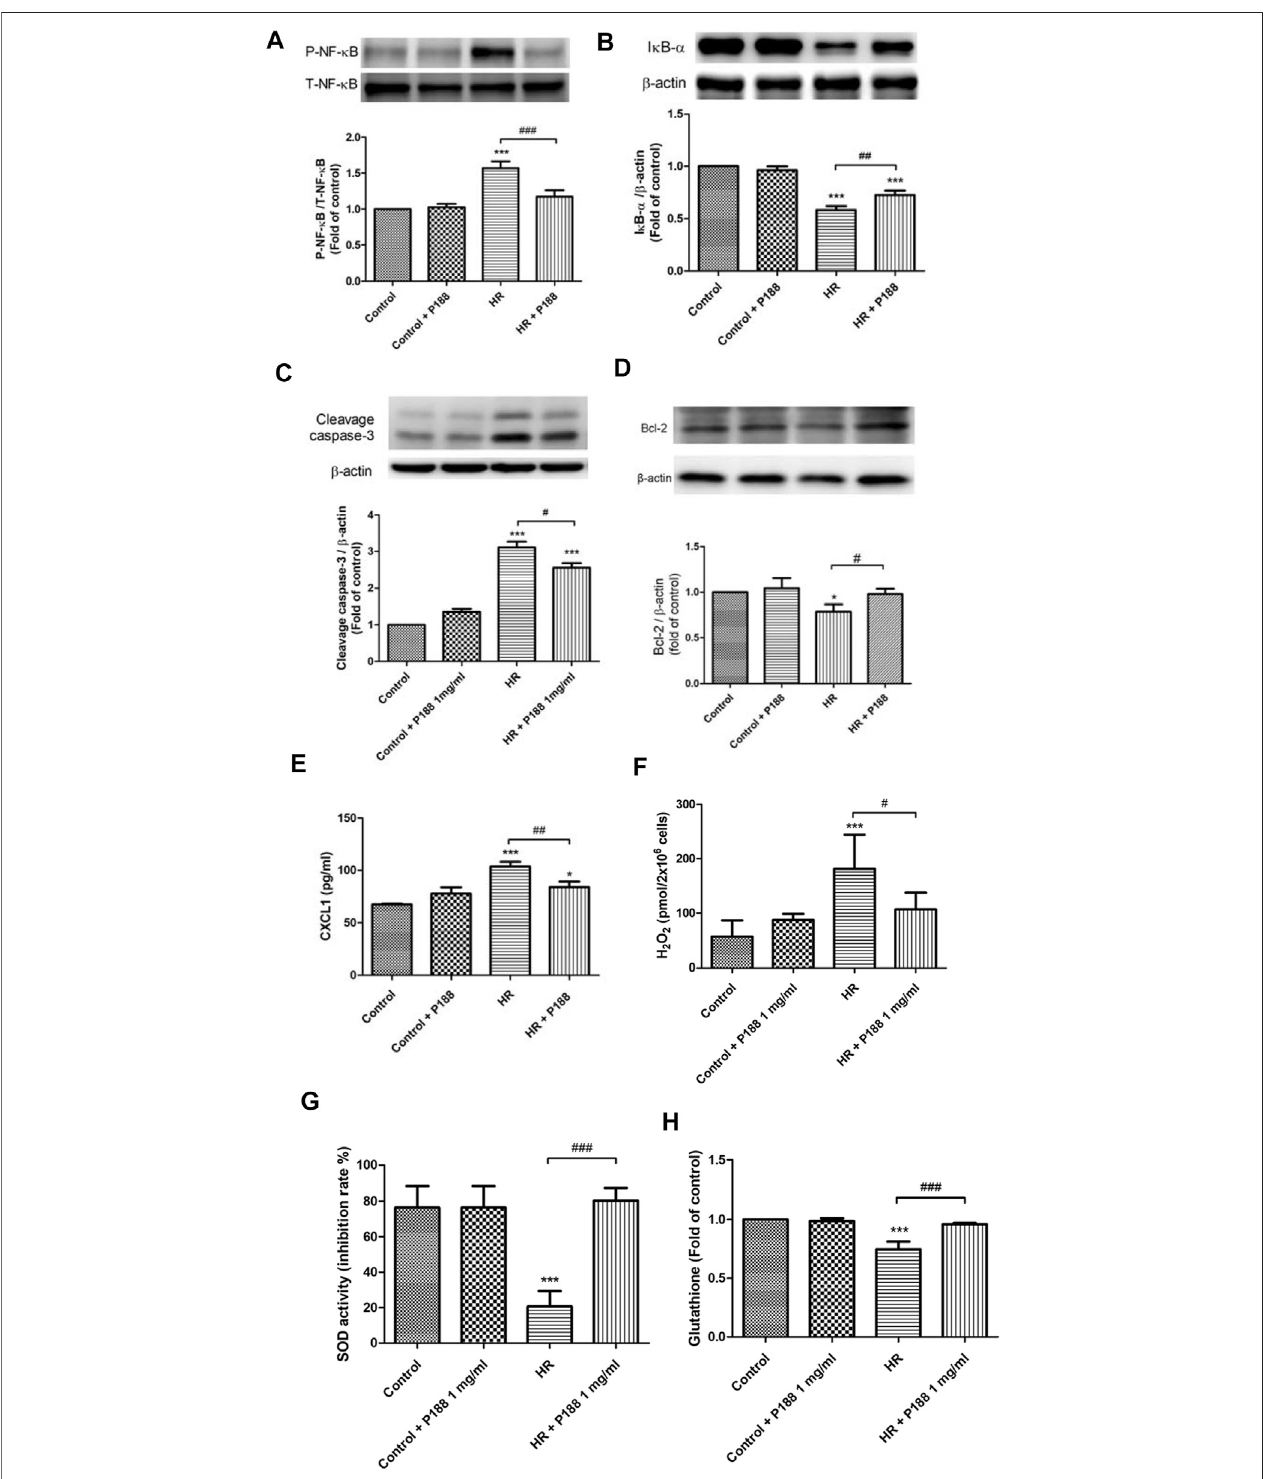
FIGURE 6 | Effect of P188 on hypoxia/reoxygenation (HR) injury in MLE-12 cells. NF- κ B phosphorylation (A) , I κ B- α degradation (B) , cleaved caspase-3 (C) and Bcl-2 (D) protein expression, CXCL-1 (E) , hydrogen peroxide (H 2 O 2 ) (F) , superoxide dismutase (SOD) (G) , and glutathione (GSH) (H) levels were measured at 2 h after HR. β -actinservedastheloadingcontrol.Arepresentativeblotisshown.Dataaremean ± SD( n (cid:2) 6pergroup);* p < 0.05,*** p < 0.001comparedwiththecontrolgroup. # p < 0.05, ## p < 0.01, ### p < 0.001 compared with the HR group.